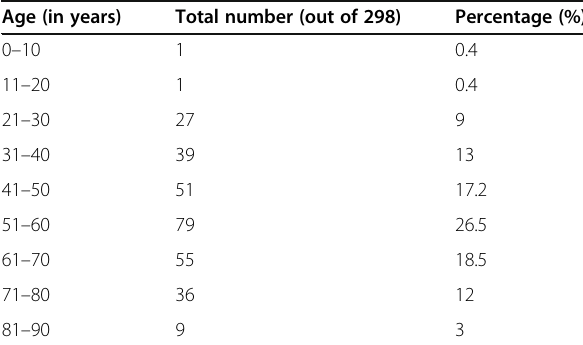
Table 1 Age distribution of the cohort